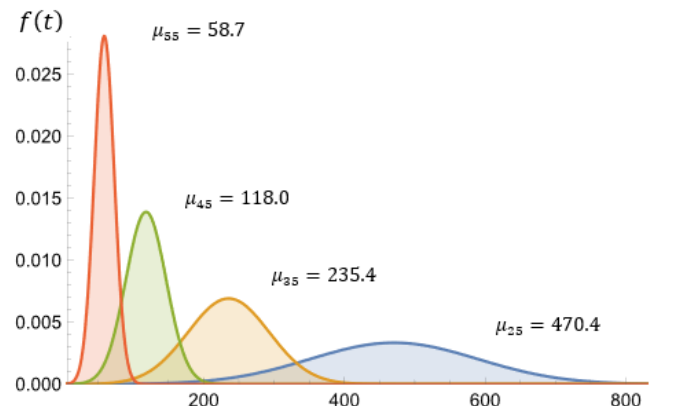
Figure 2. Battery Life Distributions Under Several Thermal Stresses.